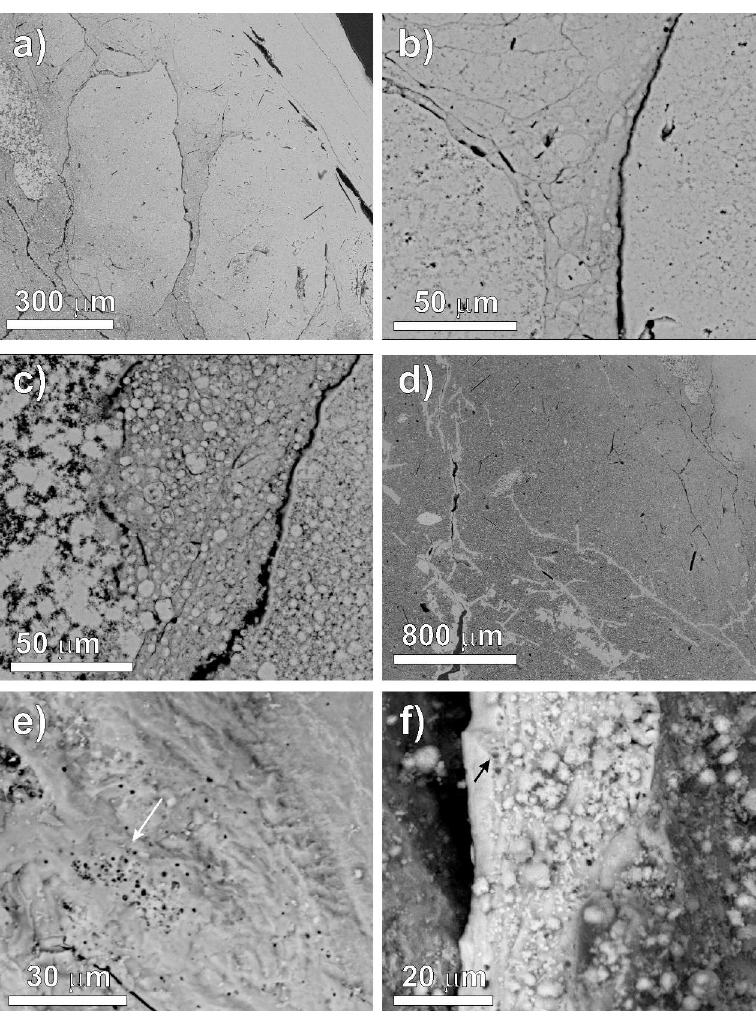
c) detail of the dense packingof crystals which form micron-sized spheresin some cases with a geode type structure and (on the left) acicularcrystals aggregateof apatite; d) micro-fractures crossing the stone, filled by secondary calcite; e-f) micro-pores due to